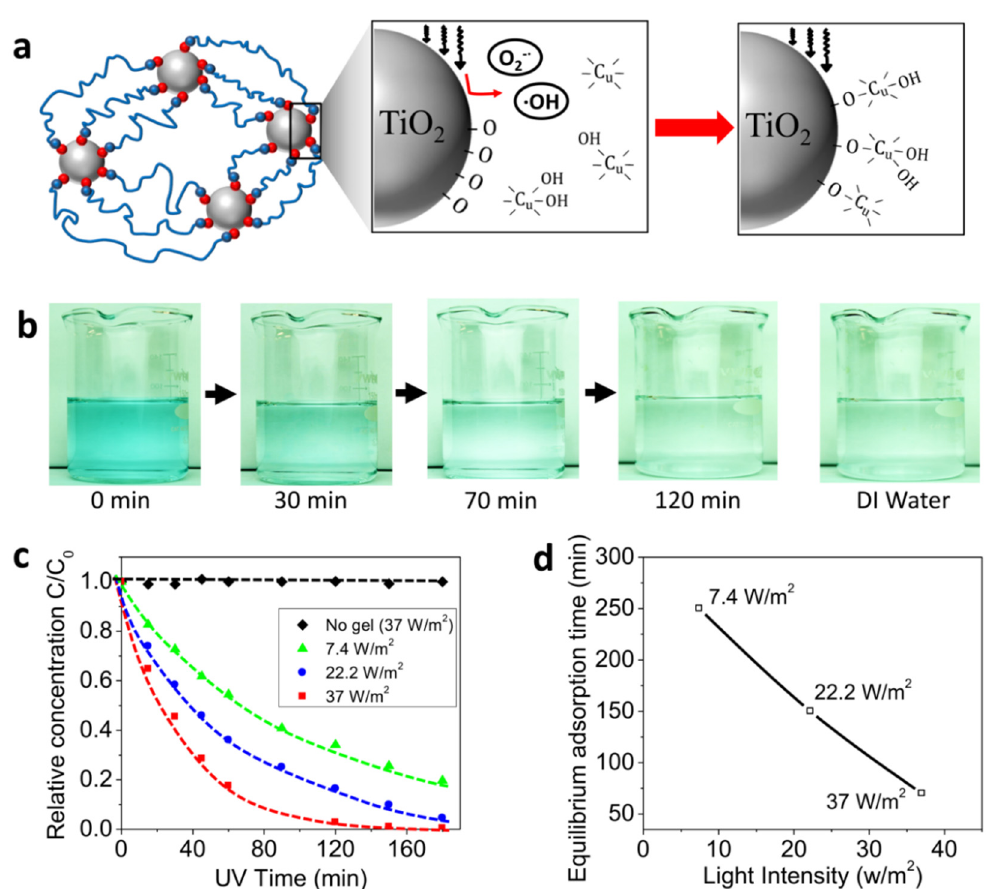
Figure 3. ( a ) Schematics to show the mechanism of the light ‐ assisted adsorption of copper ions (Cu 2+ ) on the TiO 2 nanoparticle surface. ( b ) Image sequences of the treated Cu 2+ solution after the UV light ‐ assisted adsorption for various adsorption times. ( c ) The relative concentrations of Cu 2+ as functions of UV exposure time for various UV light intensities. C and C 0 denote the concentrations of Cu 2+ in the treated and original solutions, respectively. ( d ) The equilibrium adsorption time as a function of the light intensity. The equilibrium adsorption time is defined as the UV exposure time corresponding to the relative concentration C / C 0 around 10%.